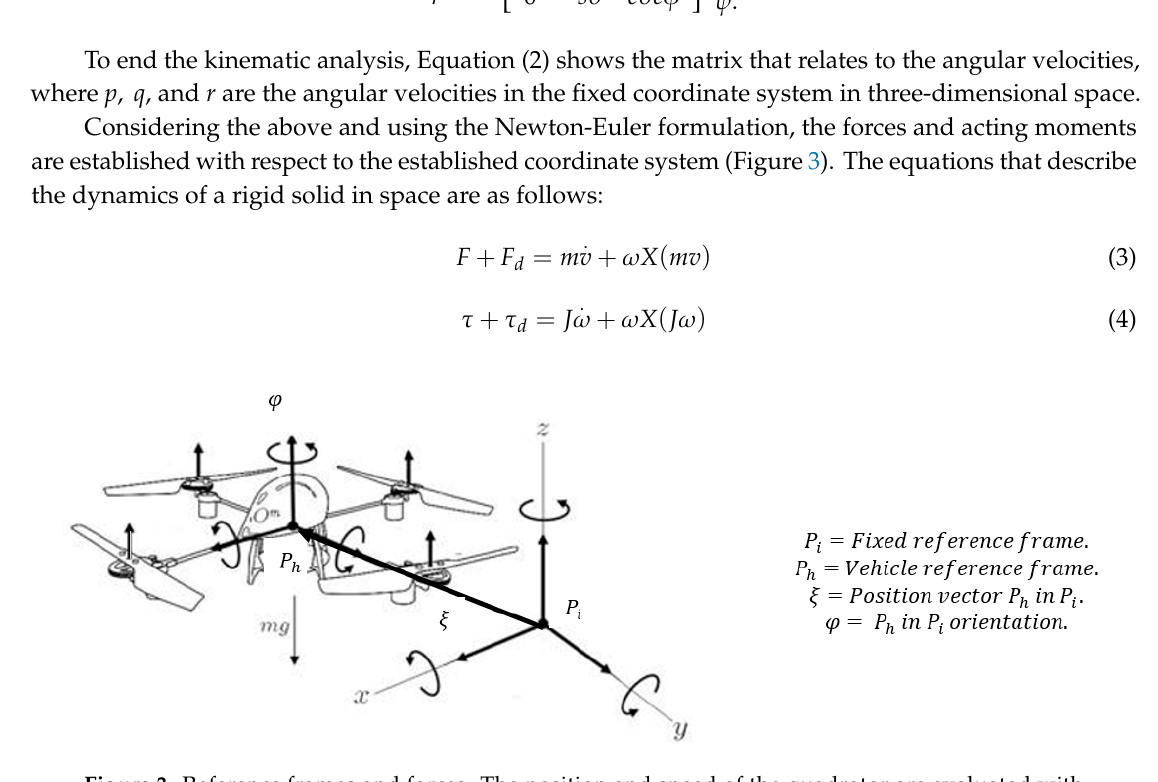
Figure 3. Reference frames and forces. The position and speed of the quadrotor are evaluated with respect to an inertial frame located at a fixed station.